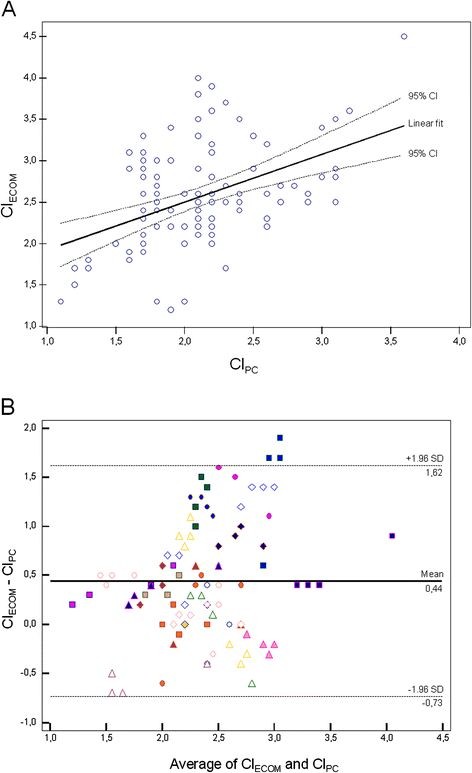
Relationship between CIPCand CIECOMin 25 patients (100 paired data points). The linear fit is given with 95% confidence interval (A); Bland-Altman analysis between CIPC and CIECOM in 25 patients (100 paired data points). The mean bias is given with its limits of agreement (B). CIECOM = cardiac index determination using ECOM (L.min-1.m-2); CIPC = cardiac index determination using pulse contour analysis (L.min-1.m-2).